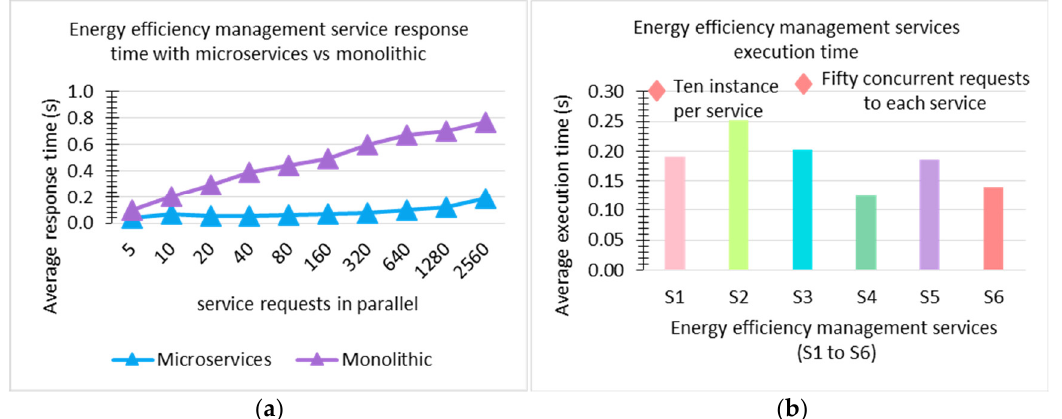
Figure 13. ( a ) Comparison of energy efficiency management service response time in microservices vs. monolithic with a number of service requests ( b ) Average end-to-end execution time for six energy efficiency management services with many instances and concurrent requests.